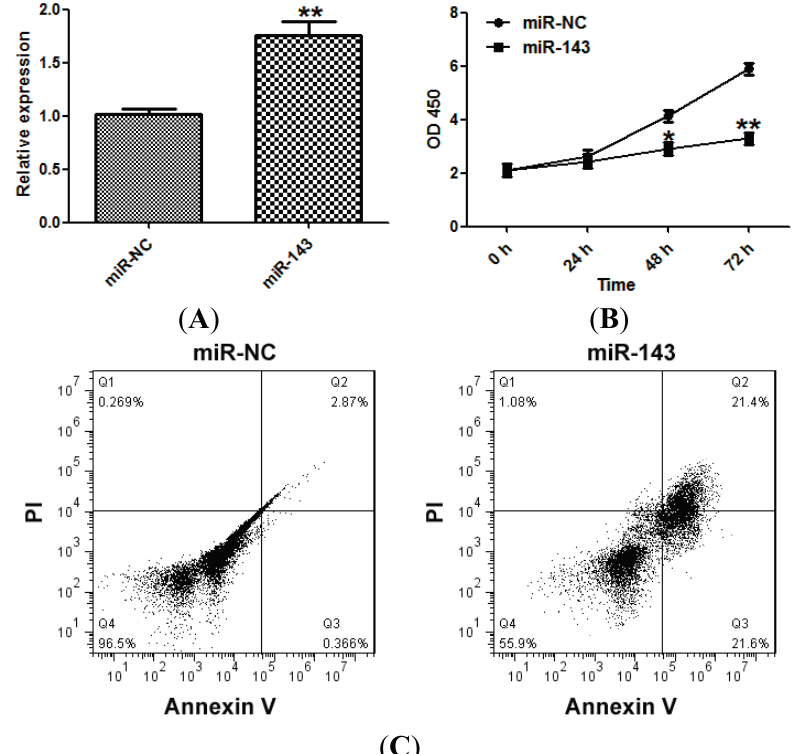
Figure 2. miR-143 suppresses the proliferation of NSCLC cells. ( A ) NCI-H23 cells were transfected with miR-143 or control mimic (miR-NC), and the expression of miR-143 was measured by qRT-PCR; ( B ) Cell viability assay (CCK-8); and ( C ) Apoptosis assays. Experiments were performed in triplicate. * p < 0.05, ** p < 0.01 compared with control.